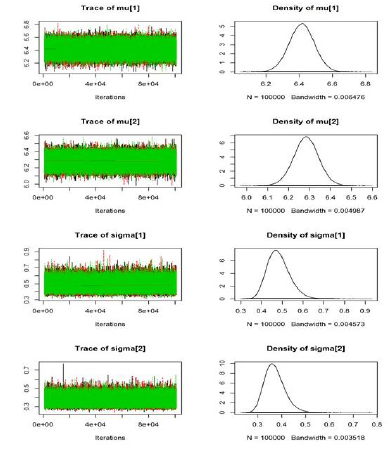
Fig. 10. Estimate difference in metformin Clr between Metformin +Daclatasvir (D) and Metformin only (ND)